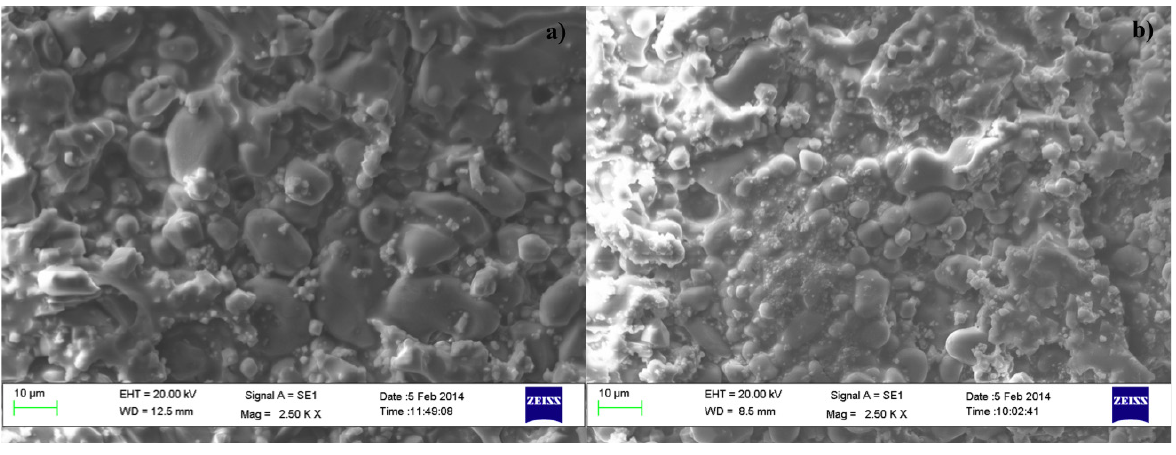
Figure 7. SEM micrographies (2500×) of the fired surface of samples with composition: OA5 ( a ) and OA10 ( b